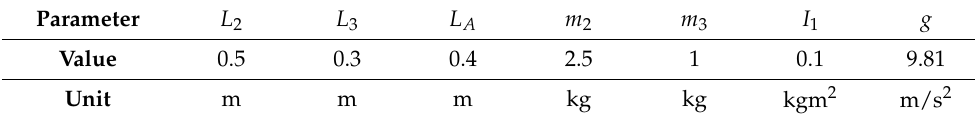
Table 2. Numerical values of the robot’s constant